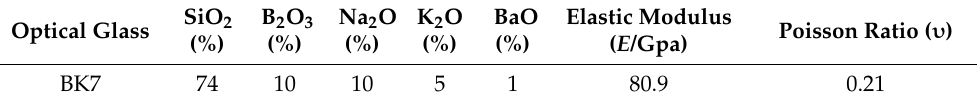
Figure 1. Experimental setup.